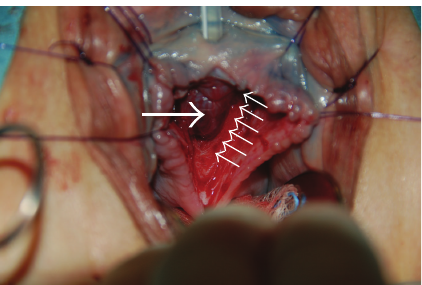
Figure 8: The urethral mucosa (long white arrow) is visible after excision of the urethral diverticulum. The dorsal muscular components (small white arrows) of the urethral sphincter complex are completely cut longitudinally thereby exposing the urethral mucosa from bladder neck up to the meatus.